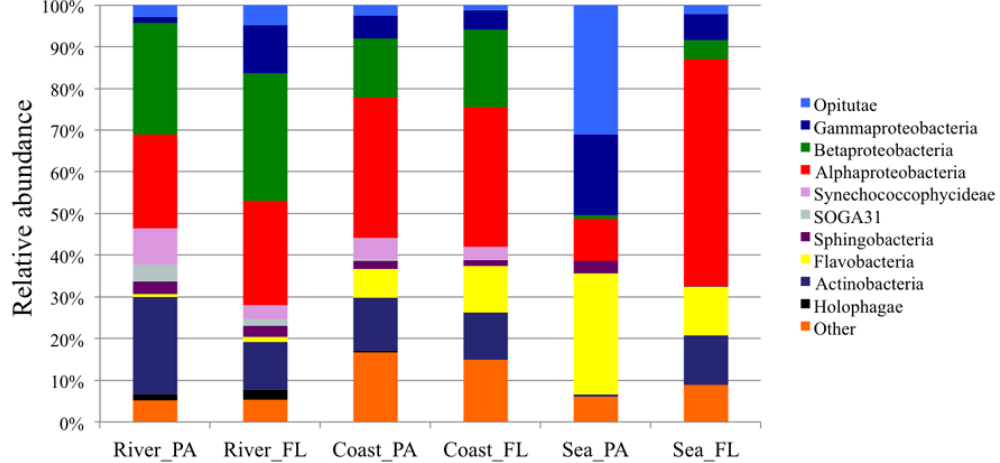
Fig. 6. Cumulative bar charts comparing the relative class abundances in particle-attached (PA) and free-living (FL) selected samples. Table 4. Number of OTUs at 0.03 level of clustering, and Chao1, Shannon and Simpson diversity indexes after 454-tag pyrosequencing for the selected samples. PA: particle-attached. FL: free-living. Sample Fraction N reads N OTUs Chao1 Shannon Simpson